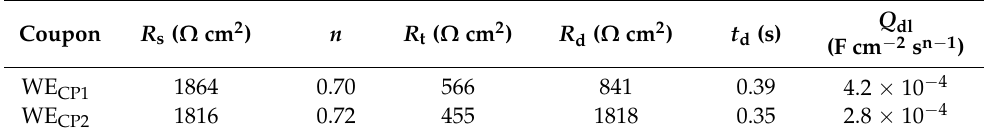
Figure 7. EIS modelling: Nyquist plots for coupon WE CP1 ( a ) at OCP at day 7 and ( b ) under CP at day 70. Owing to a lower R s value, the data obtained at day 70 were usable from 100 kHz to 100 mHz. Table 2. Fitted values of EIS data for both coupons at OCP (day